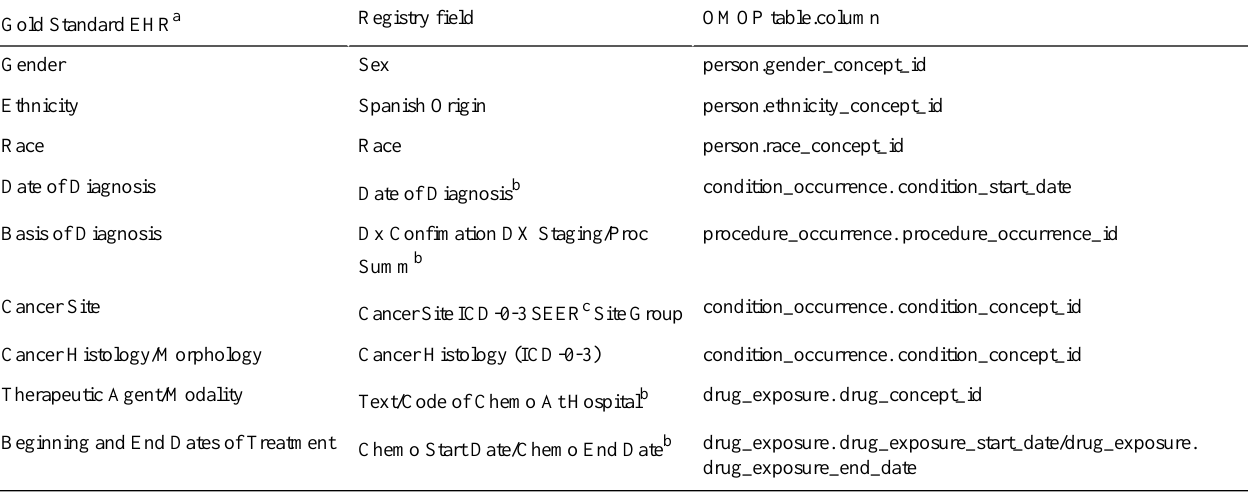
Table 1. Breakdown of data elements for registry/Observational Medical Outcomes Partnership.